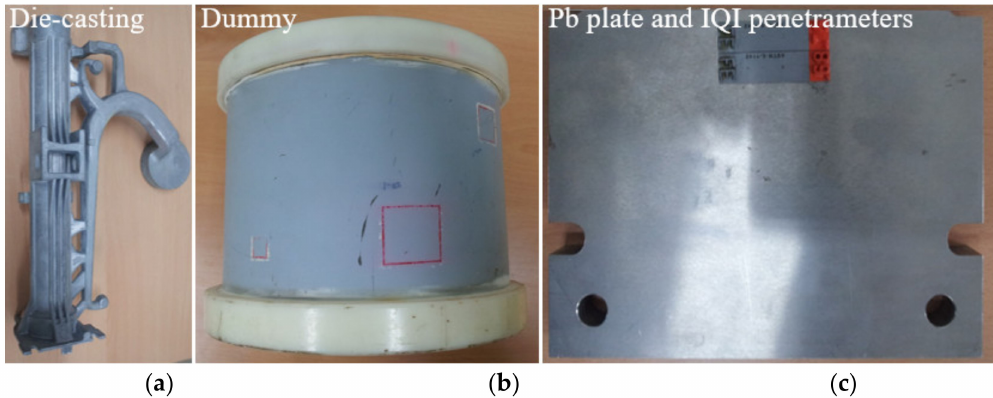
Figure 3. Photographic images of the ( a ) aluminum die-casting, ( b ) concrete dummy, and ( c ) 50 mm Pb plate attached to the image quality indicator (IQI) penetrameters for the